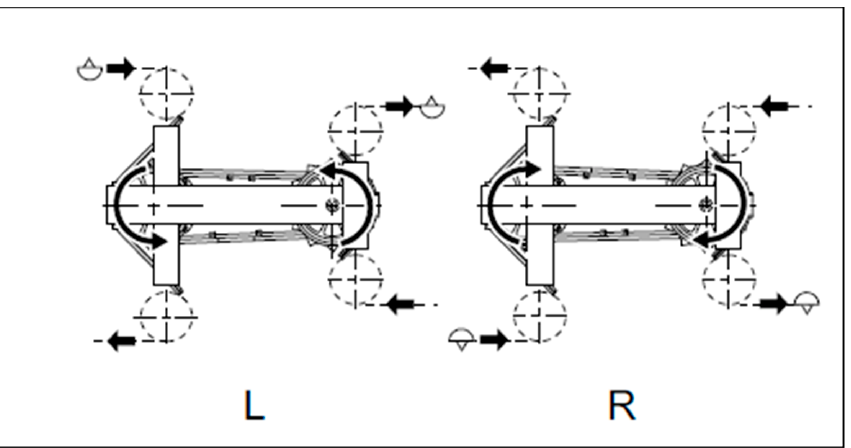
Figure 2. TR-CS top